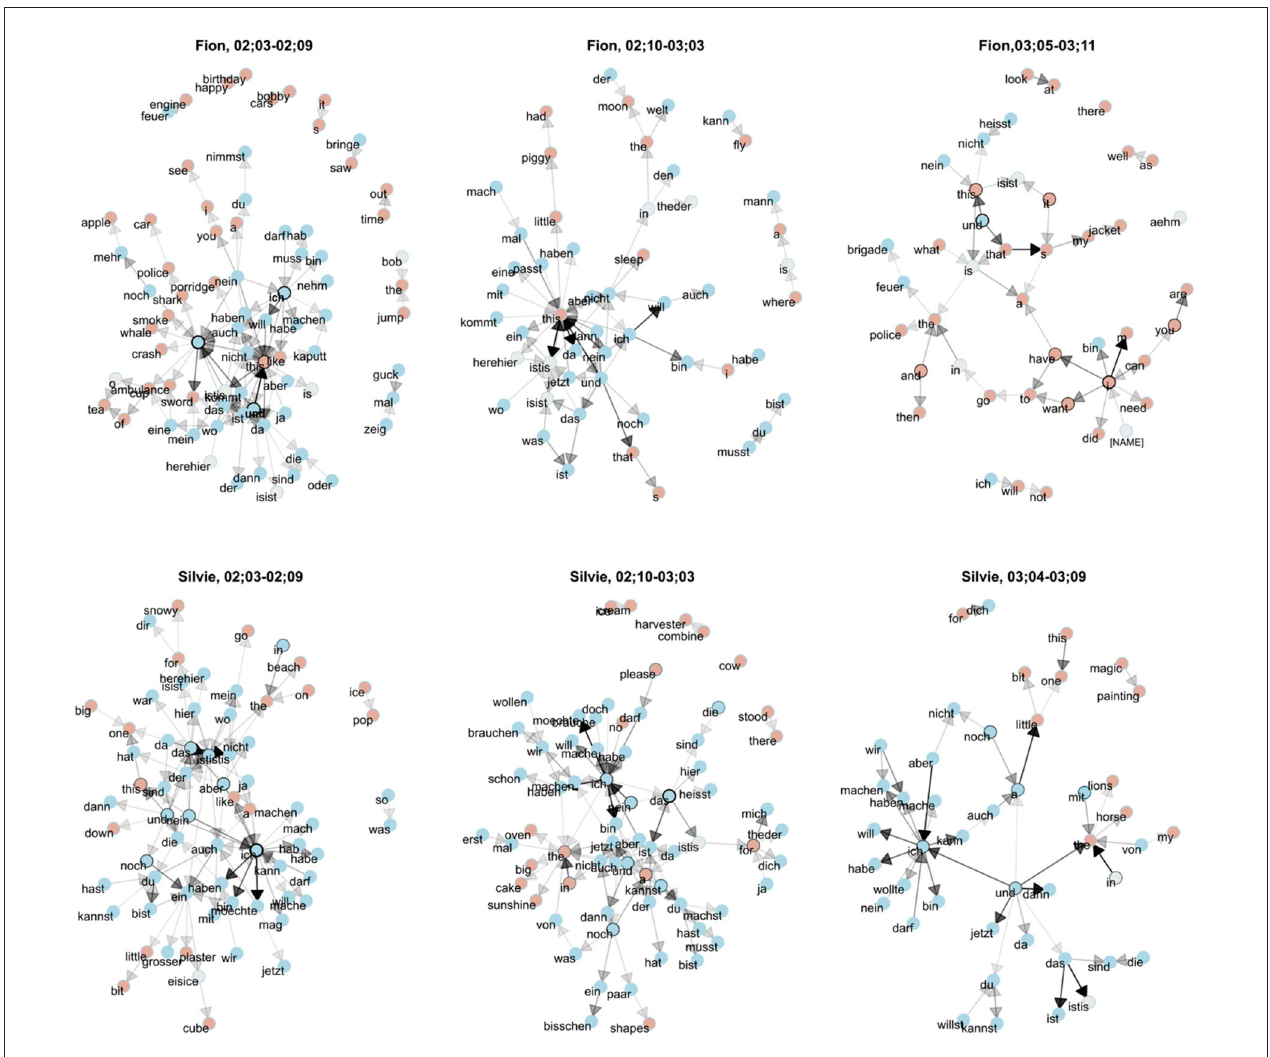
FIGURE 4 | Bigram network based on all code-mixed utterances in the corpus, created using ggraph (Pedersen, 2021). highlighted in boldface, ich “I,” is often followed by will